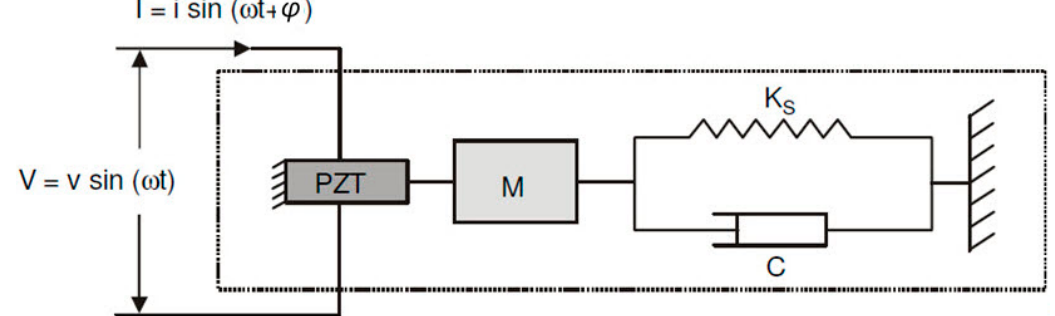
Figure 1. Electromechanical coupling between the PZT patch and the host structure.